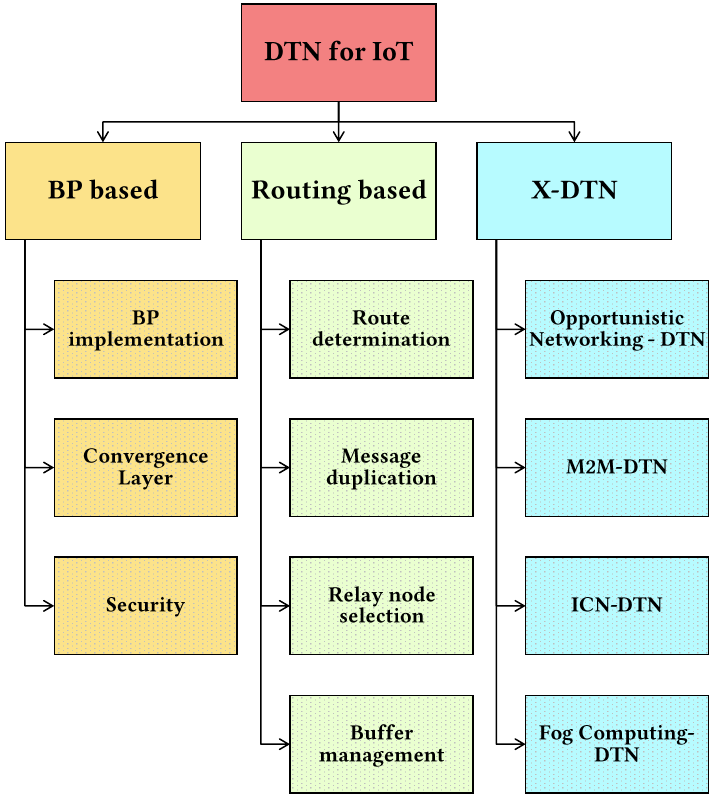
Figure 3. Classification of DTN solutions for